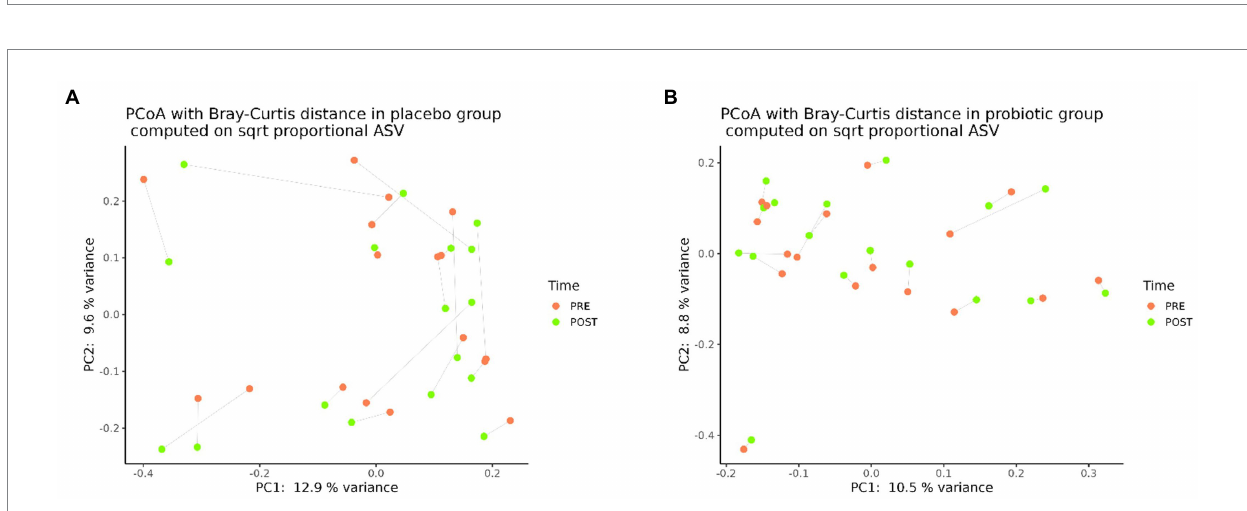
FIGURE 2 Principal coordinates analysis (PCoA), according to the Bray-Curtis beta-diversity metric, of pre- ( n = 20) and post- ( n = 20) placebo samples (A) and pre- ( n = 20) and post- ( n = 20) probiotic samples (B)